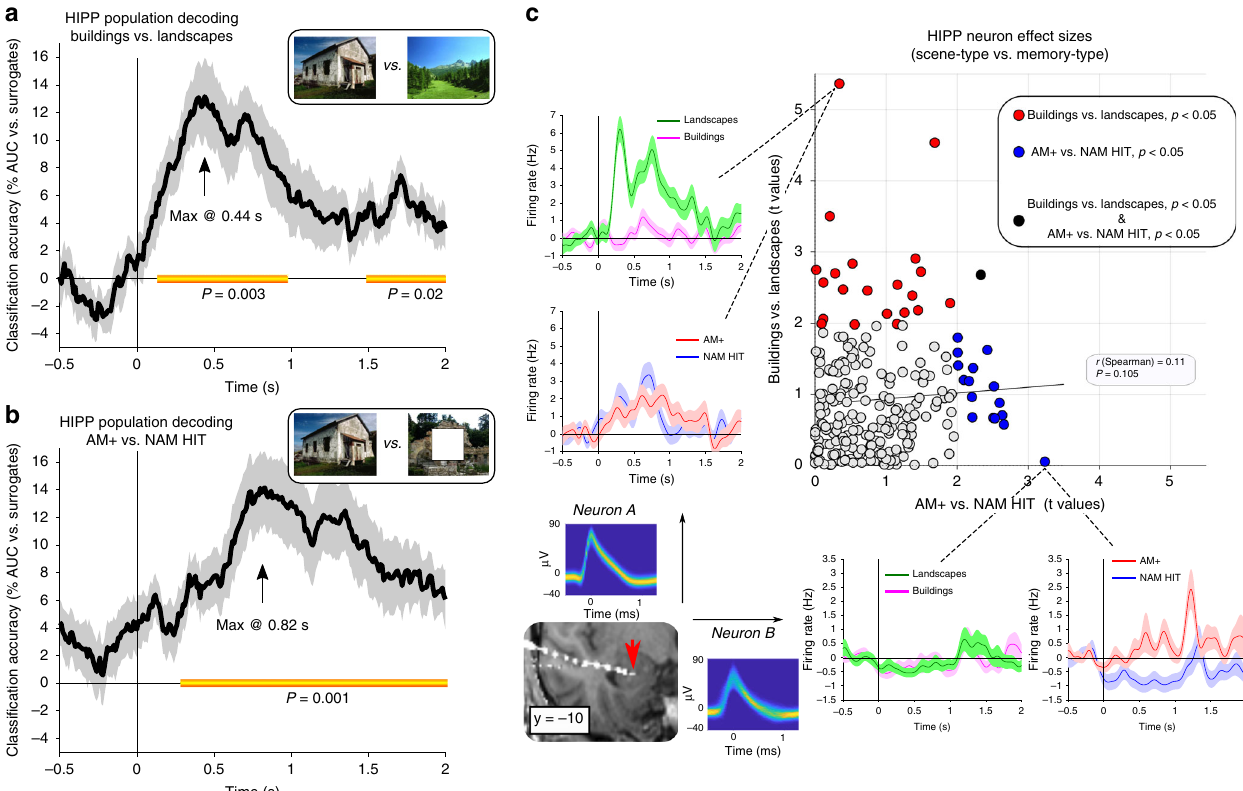
Fig. 5 Two independent populations of hippocampal neurons code for scene type and memory type. a Decoding of scene type (buildings vs. landscapes, both collapsed across NAM HIT and AM + ) across time (10 ms steps; x -axis re fl ects decoding time points after averaging fi ring rates in a + / − 250 ms window). b Decoding of memory type (AM + vs. NAM HIT, both collapsed across buildings and landscapes). c Scatter plot shows each HIPP neuron ’ s effect size (abs t -values) for the contrast of AM + vs. NAM HIT ( x -axis) and the contrast of buildings vs. landscapes ( y- axis), based on baseline-corrected mean fi ring rates from 0 – 2 s after stimulus onset. Black line is the least-squares regression fi t. Filled circles denote neurons showing a scene-type effect (red), a memory-type effect (blue) or both (black) (calculated via independent samples t -tests across trials for each neuron, P < .05 uncorrected). Insets show mean instantaneous fi ring rates for the two neurons showing the strongest effects, both incidentally stemming from the same participant and the same microwire bundle (red arrow; shown on the normalized post-implantation MRI). Waveforms of the two neurons ’ respective action potentials are depicted as temperature-scaled density plots. Scene images obtained from https://commons.wikimedia.org under the CC-BY-SA-3.0